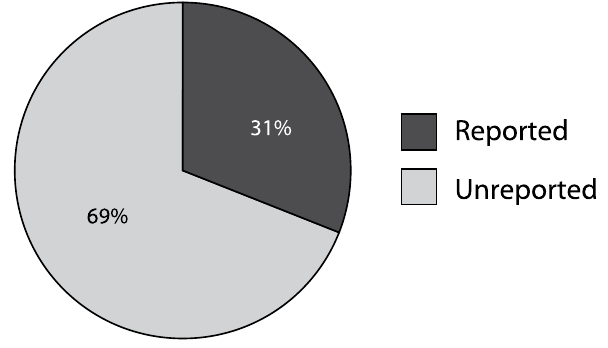
Figure 6: Number of participants who reported the pathological vestibular symptoms to healthcare workers versus the number of participants who did not ( N =